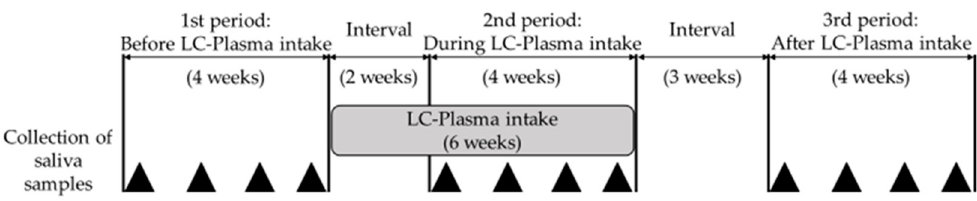
Figure 1. Study design: Four saliva samples were collected during each period, and HHV-6 and HHV-7 DNA loads were measured by real-time PCR. After the 4-week first period, all subjects took Lactococcus lactis strain Plasma (LC-Plasma) for 6 weeks. Two weeks after initiation of LC-Plasma intake (the period required for expression of effects), the subjects entered the second period. After a 3-week washout period, the subjects entered the third period. The black triangles indicate the time points when saliva samples were collected from the subjects.